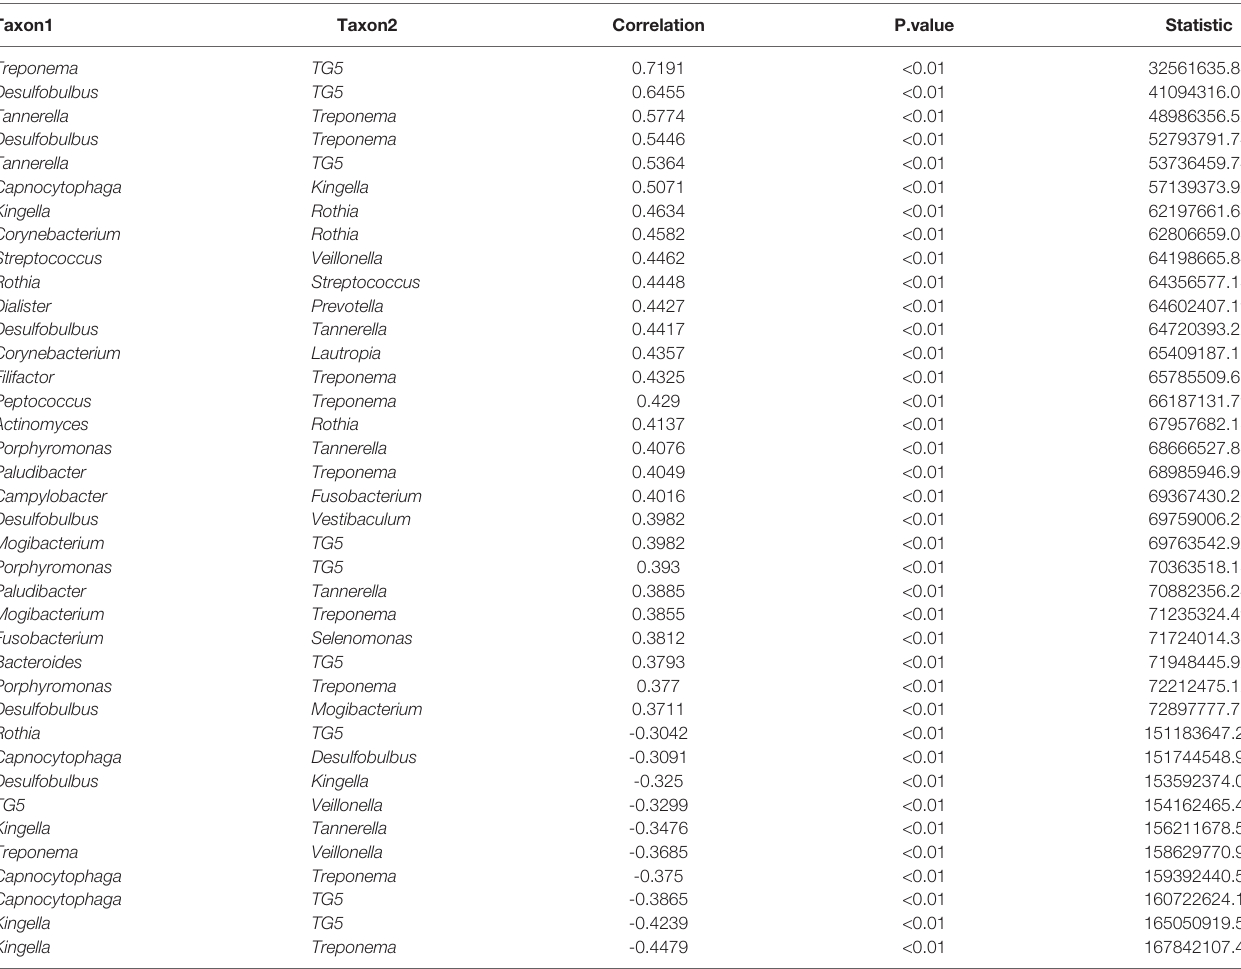
TABLE 2 | Correlation network analysis of the microbial community.